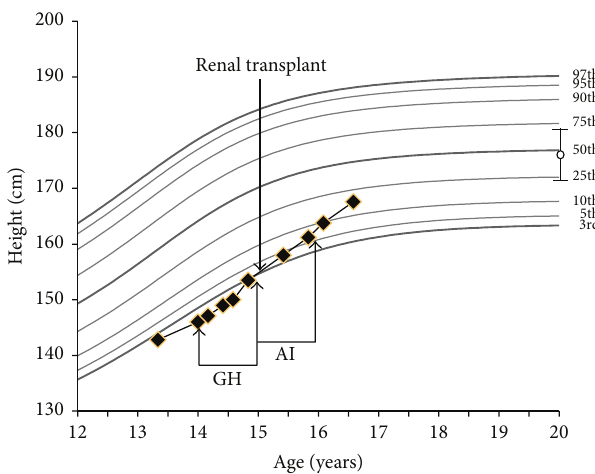
Figure 1: Observed growth curve of subject with prediction of final height. GH: interval of growth hormone therapy with growth veloc- ity of 8.5 cm/year; AI: duration of aromatase inhibitor (anastrozole) therapy with growth velocity of 9.8 cm/year. Annualized growth velocity after AI therapy = 5.4 cm/year. Circle with vertical bars denotes predicted adult height by the method of Greulich and Pyle